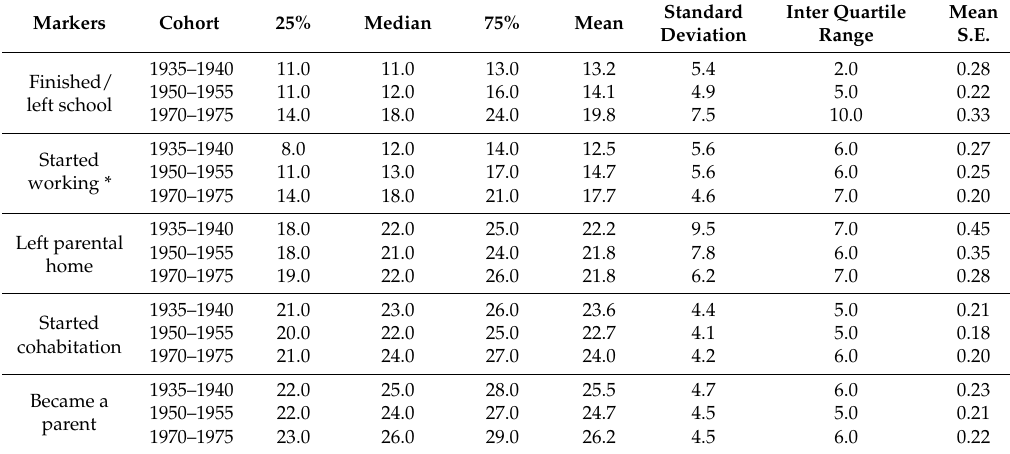
Table 2. Mean age at transitions and dispersion measures per